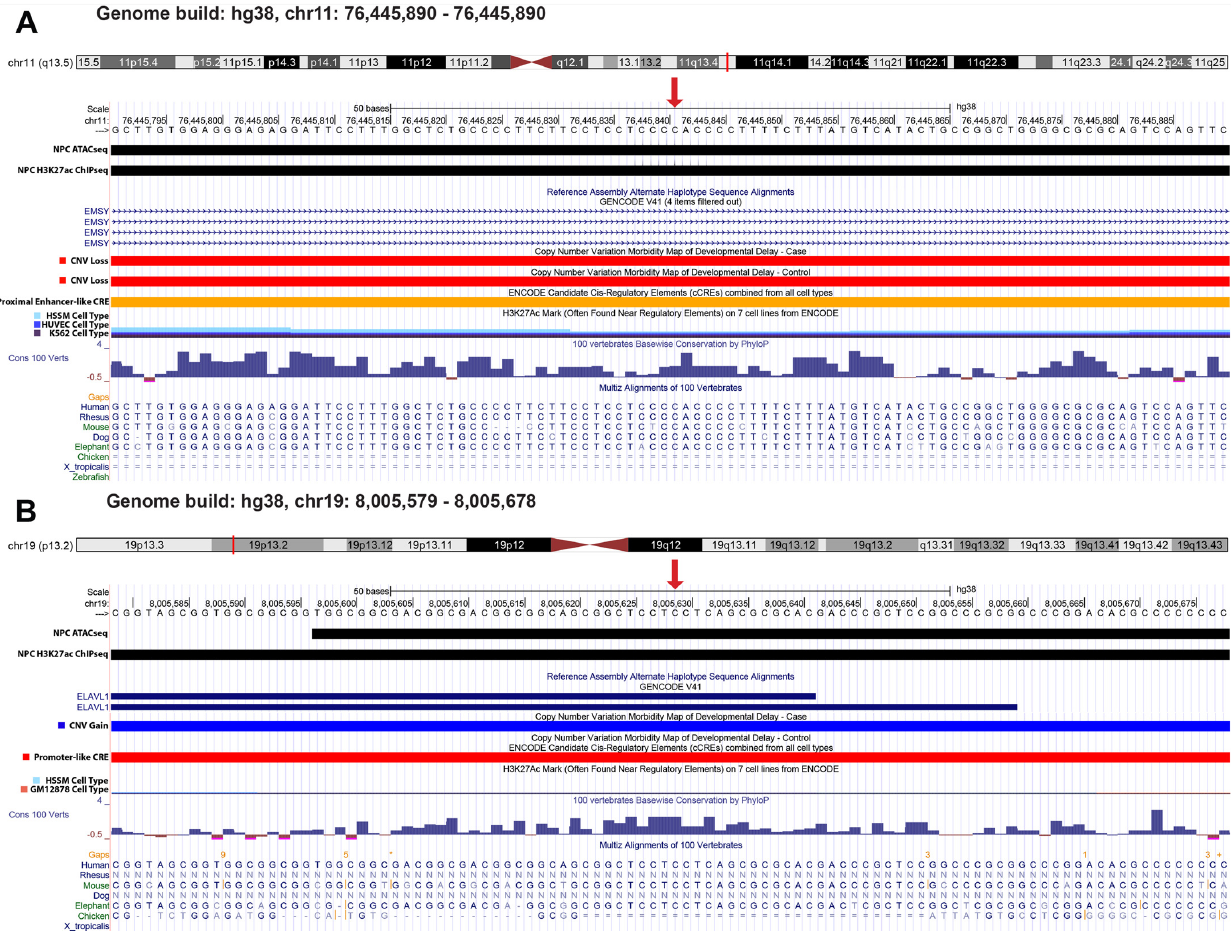
Figure 6. GC content of HcDNV variants and top scoring variants. ( A,B ) Genome browser capturing the variant locations (denoted by the red arrow) of variants affecting EMSY ( A ) and ELAVL1 ( B ). Track names are on the left with custom tracks NPC_ATAC and NPC_H3K27ac to show the ATACseq and H3K27ac ChIP-seq peak data that were gathered for this cell type.